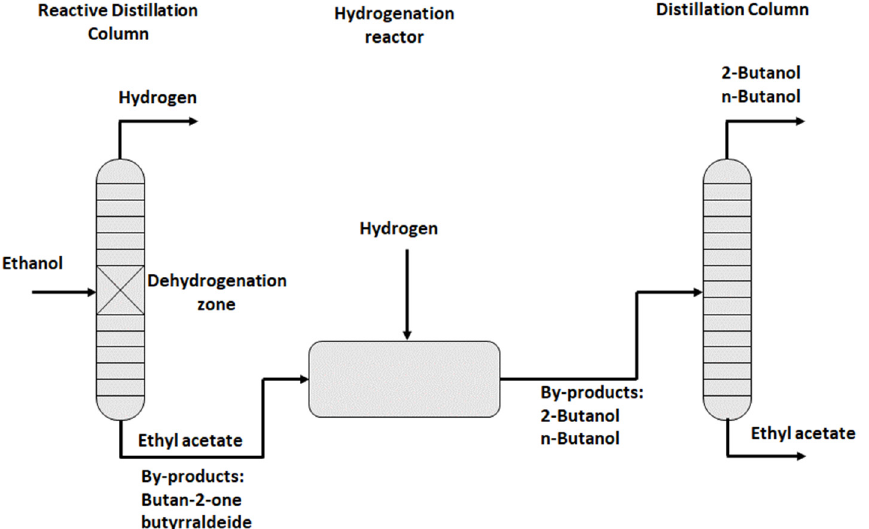
Figure 8. Simplified scheme of the Greenyung Process.